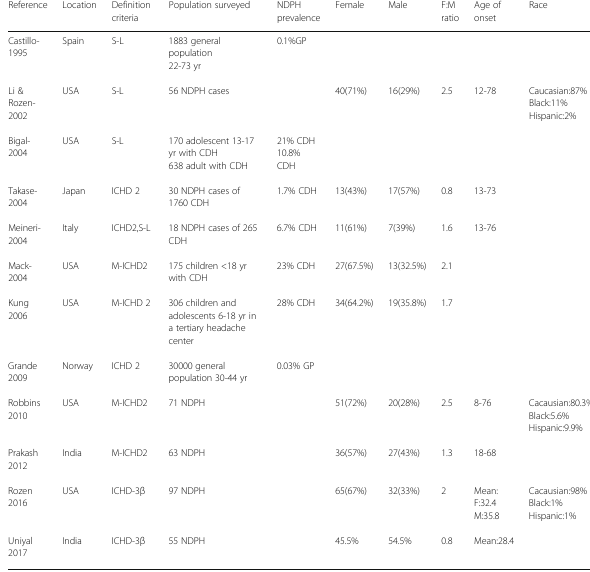
Table 1 (abstract P116). Prevalence, age , sex and race distribution of NDPH in different studies.